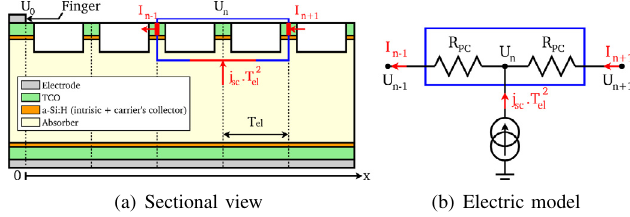
Fig. 7. Sectional view of the patterned HIT solar